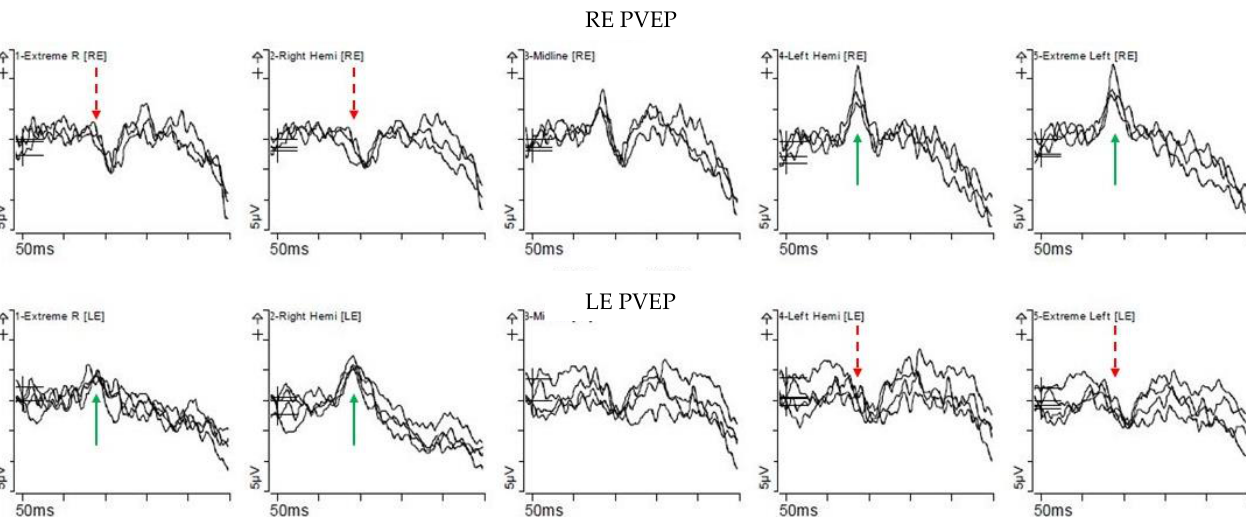
Figure 5. Pattern appearance VEPs (PVEP) from a patient (27079) with TYR mutation. PVEP responses on stimulating the right eye are displayed on the top row and those on stimulating the left eye are on the bottom row. Column 1 and 2 are responses from the right hemisphere, column 4 and 5 are responses from the left hemisphere, and column 3 is the combined midline response. PVEP shows contralateral predominance (turquoise arrow) when the opposite eye (dotted red arrow) is stimulated.